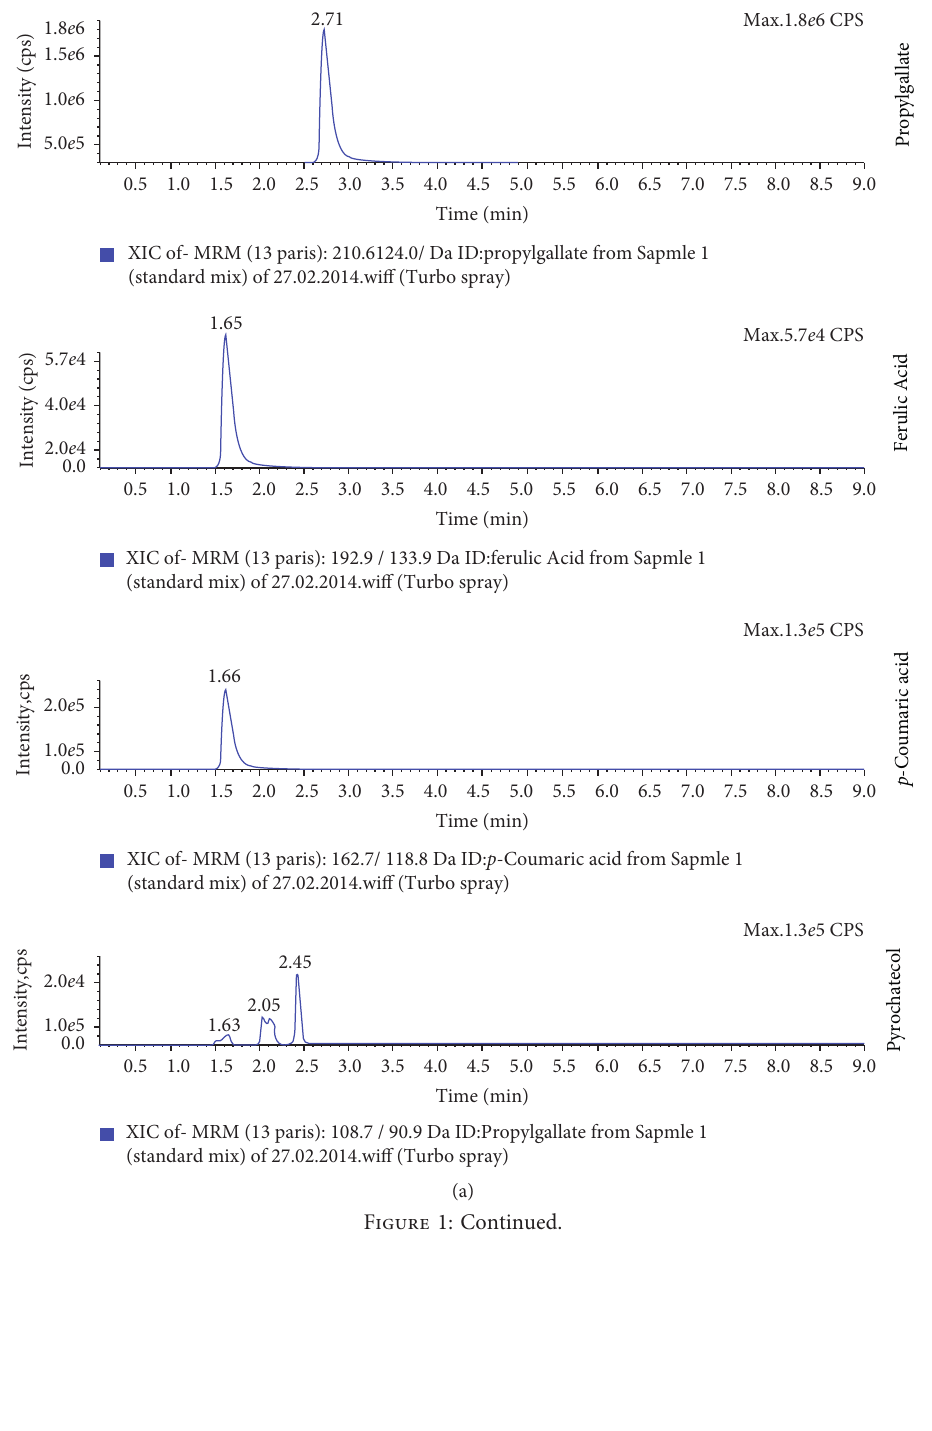
XIC of- MRM (13 paris): 210.6124.0/ Da ID:propylgallate from Sapmle 1 (standard mix) of 27.02.2014.wiff (Turbo spray)